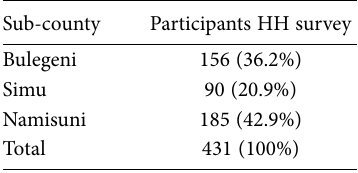
Table 1. Number of HHs participating in the